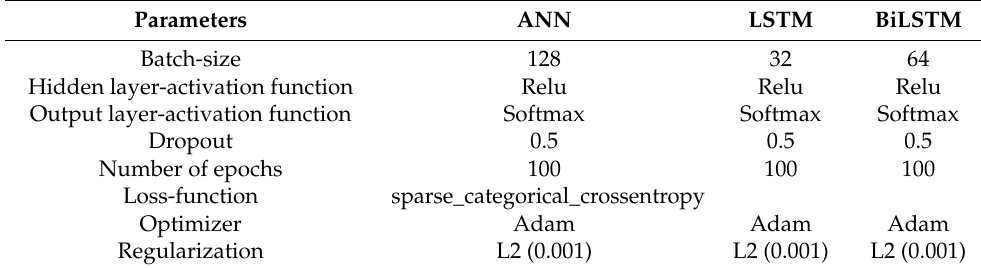
Table 9. Parameter used in ANN approach using both datasets.